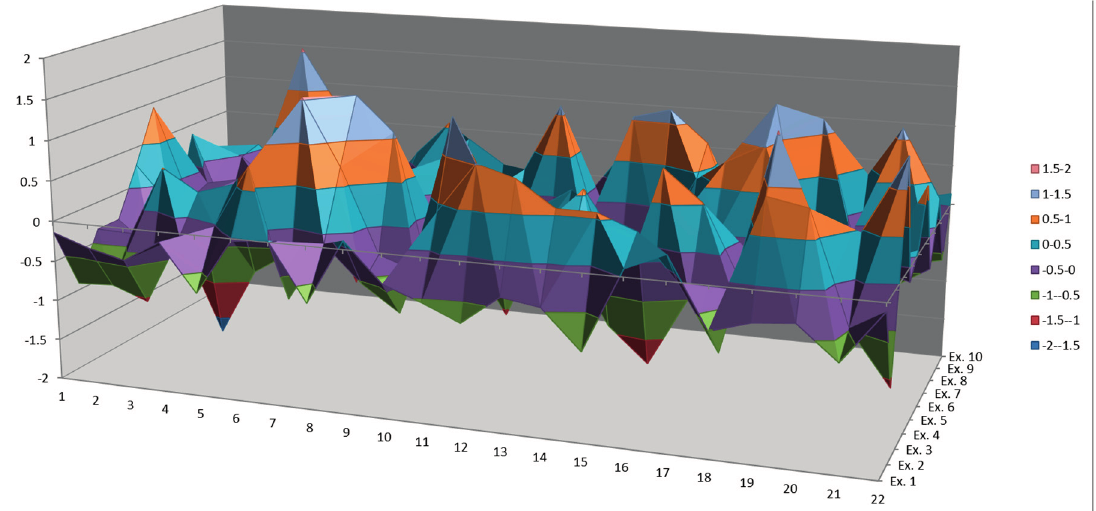
Figure 8. Evidence of non-linear relationships between the input variables. Ten examples were selected: two of each class from the traditional SoVI that changed to the two most distant classes in the ANN-extended SoVI (e.g., one high to low, one high to very low, one moderate to very high, etc.